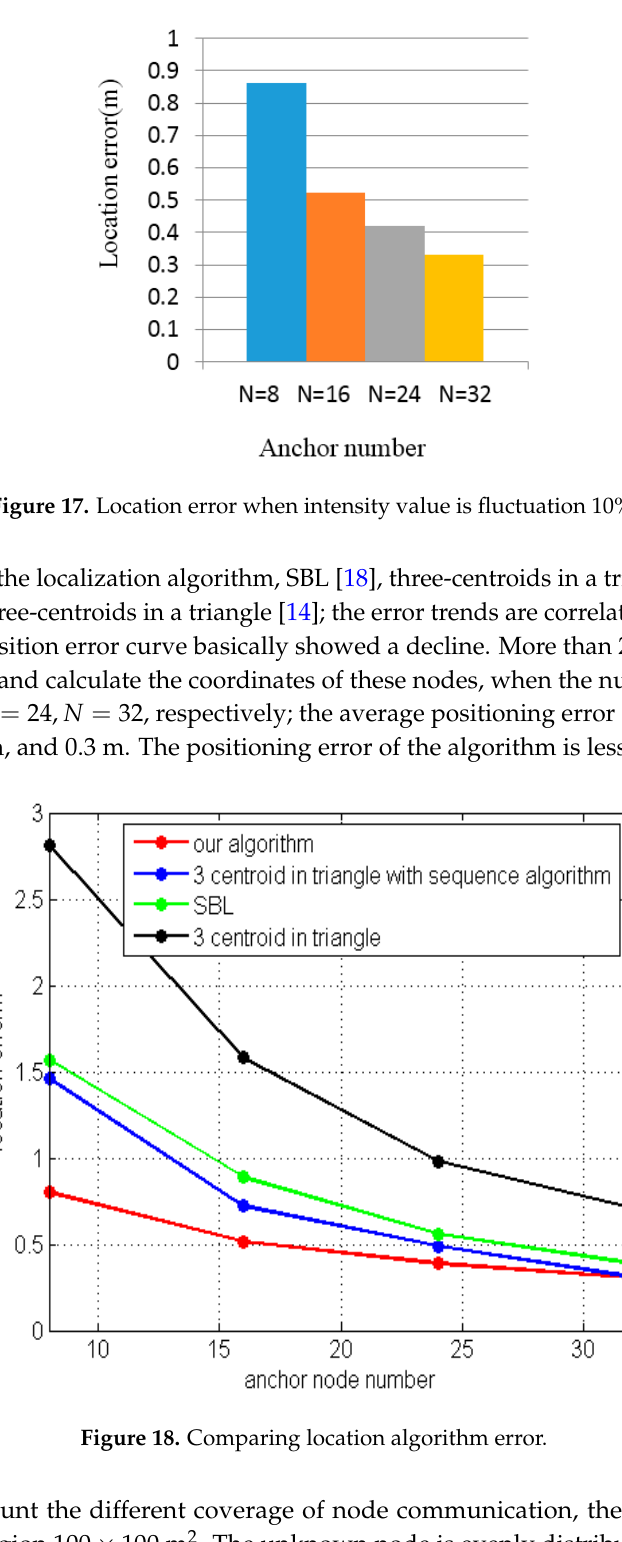
Figure 16. Location error when intensity value is fluctuation 5%.